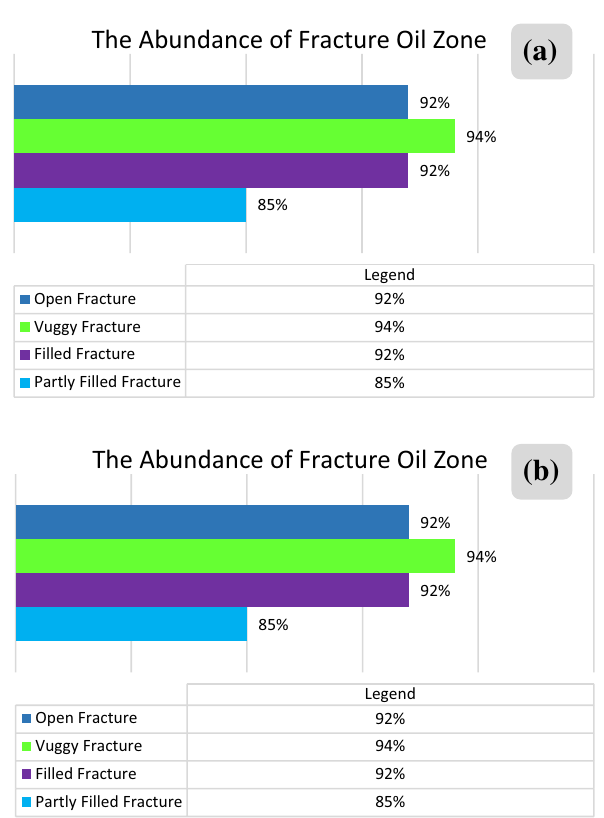
Fig. 4 Sketch showing the appearance of a fracture intersecting a wellbore at an inclined angle, and how it displays on an unwrapped image log as a sinusoidal pattern